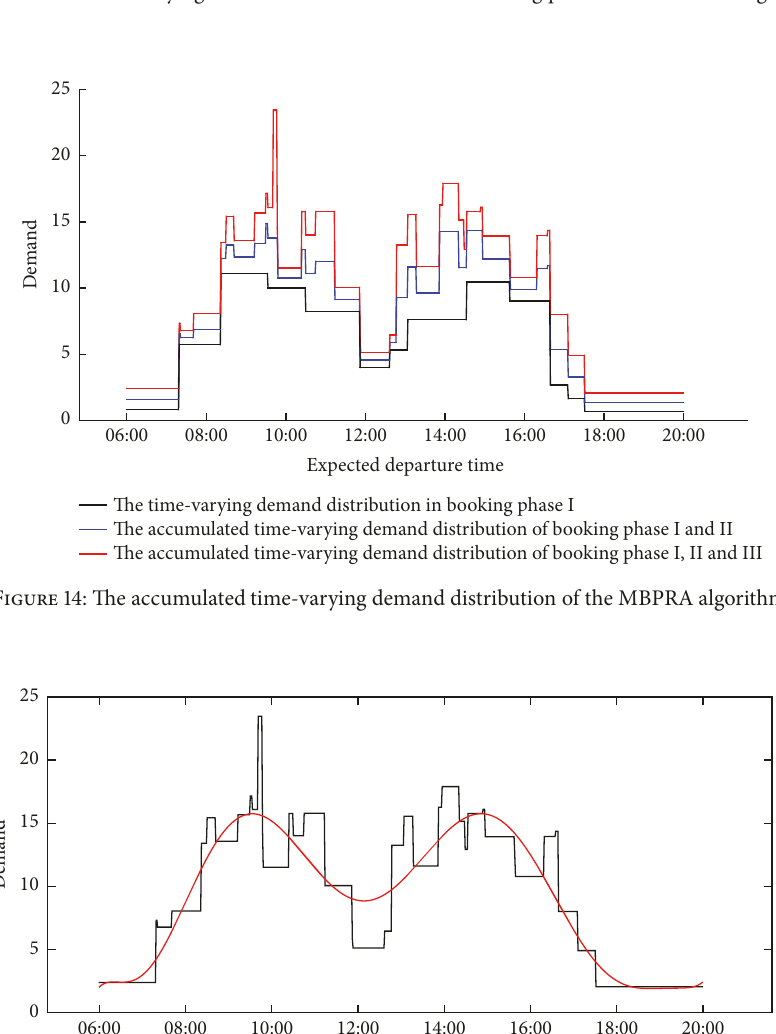
Figure 13: The time-varying demand distribution in each booking phase of the MBPRA algorithm.